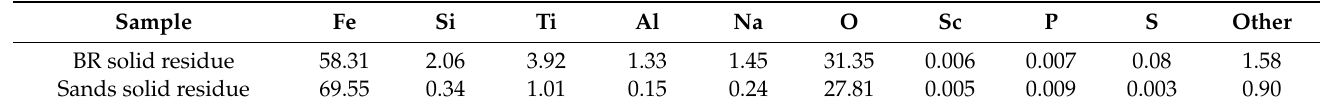
Table 5. The chemical compositions of the solid residues obtained after leaching, wt.% (T = 120 ◦ C, τ = 2.5 h, FeSO 4 -to-BR ratio of 1:1).